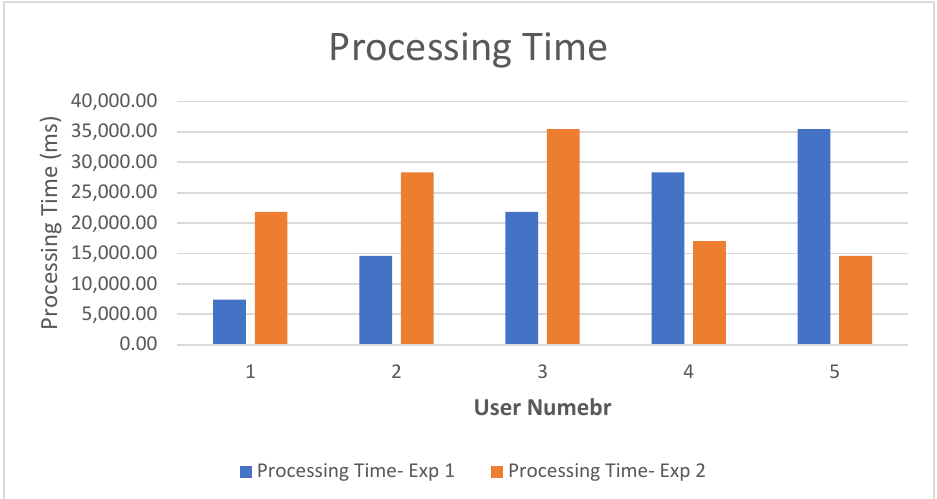
Figure 11. Time Required to Process Both sections—Experiment 2.